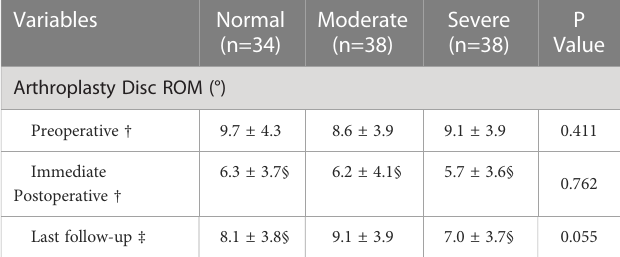
Table 3 demonstrates cervical sagittal alignment parameters of different groups. CL was signi fi cantly higher in the normal group than in the severe cohort before surgery (multiple comparisons, p = 0.029, 95% CI: 0.49-11.18), and the difference was on the verge of signi fi cance between these two groups at the last follow-up (Mann- Whitney U test, p = 0.065). Notably, SVA did not indicate a signi fi cant difference between groups before or immediately